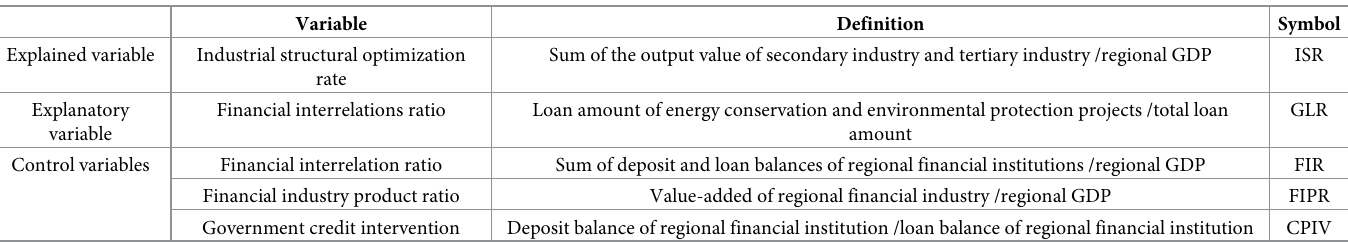
Table 2. Definition of variables.